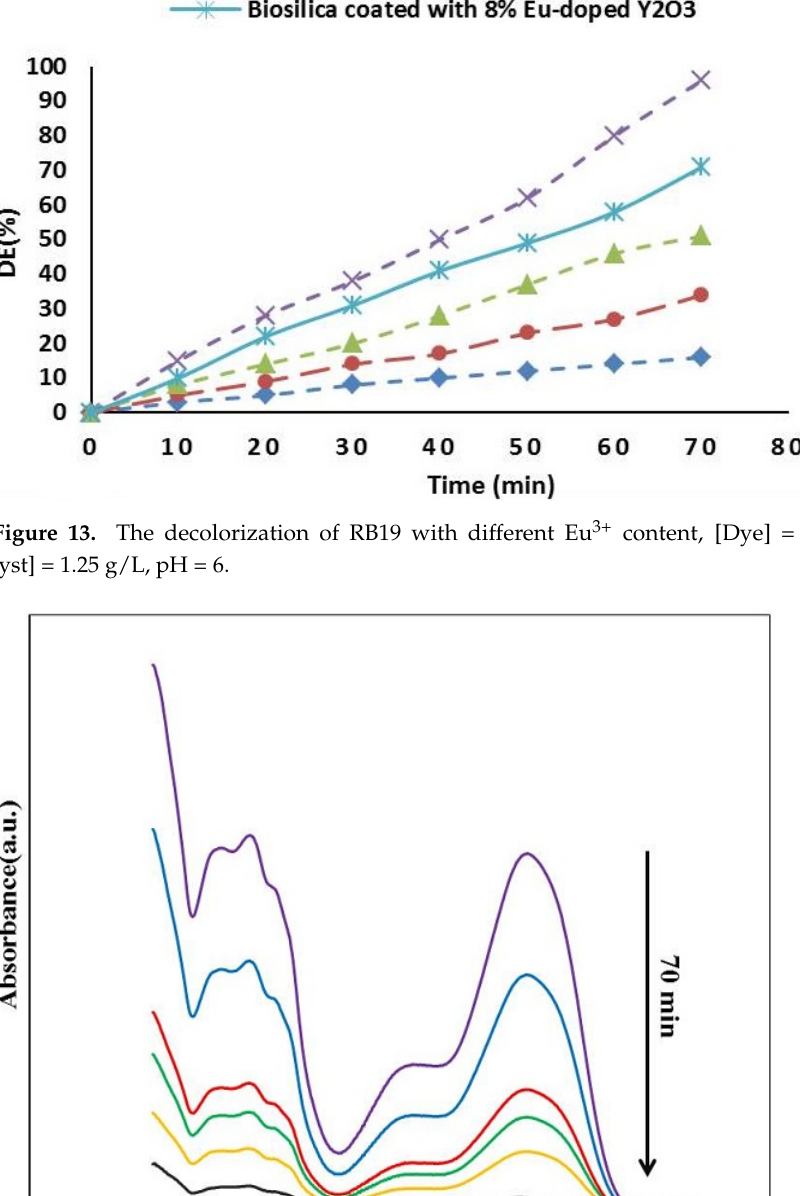
Figure 14. Degradation of Reactive blue 19 under ultrasonic irradiation using diatomite coated with 6% Eu-doped yttrium oxide.